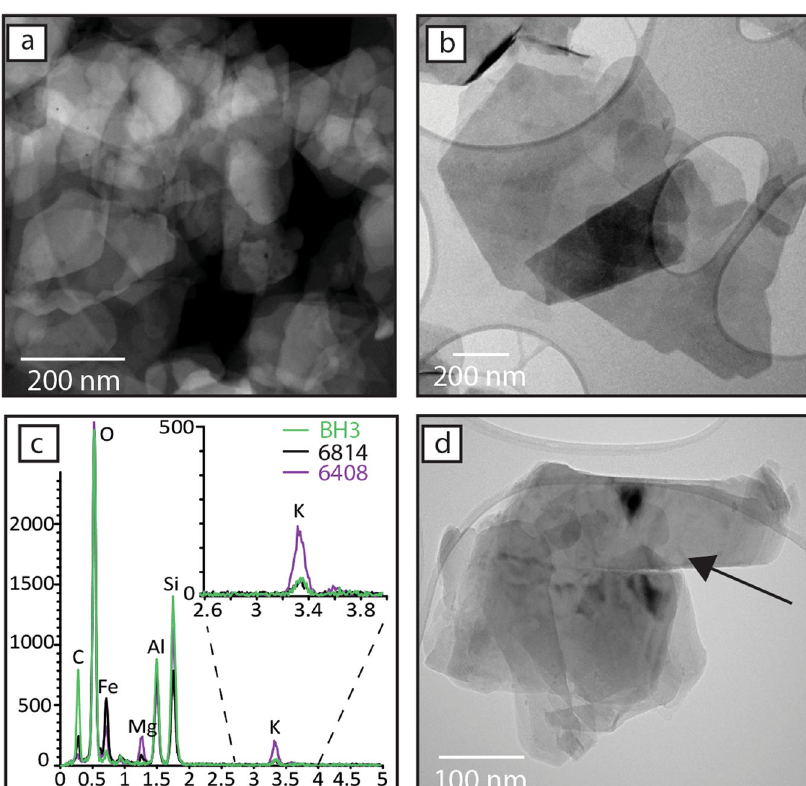
Fig. 6 Transmission electron microscopy (TEM) of the weathered basement. Photos and EDS spectra of K-bearing phases in the fi nest grain size fractions of the studied wells by TEM analyses: a Kaolinite in well 6814/04-U-01 and b 6408/04-U-01 with subhedral to euhedral morphologies. c EDS spectra showing evidence of K-bearing phases in the grain size fractions of all wells (purple: 6408/04-U-01; black: 6814/04-U-01; green: Andøya BH3). d Authigenic illite with elongated euhedral morphology (arrow) in Andøya BH3.